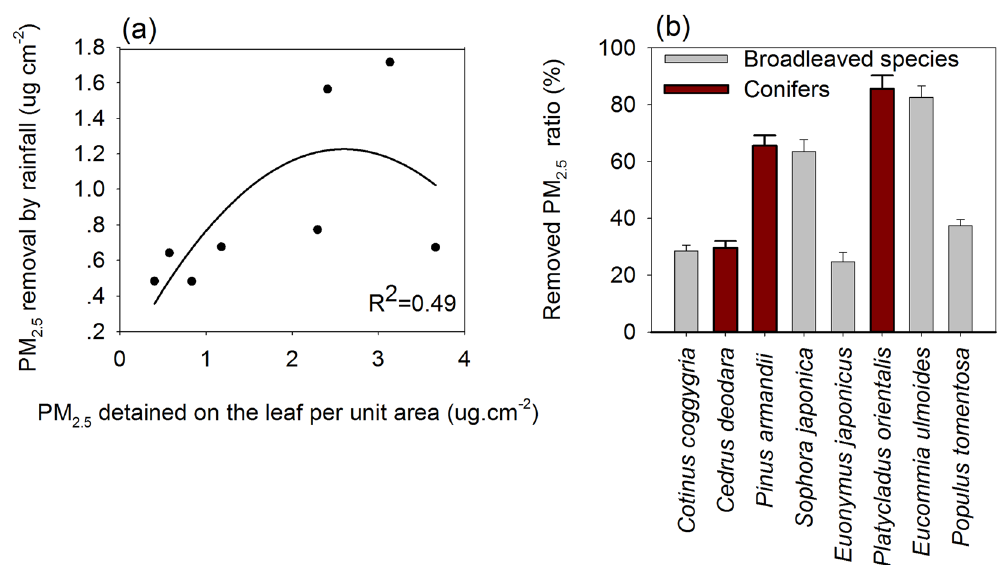
Figure 5. Foliar PM 2.5 removed by simulated rainfall (equivalent to 7.5 mm outdoor rainfall over 15 minutes) in relationship to total foliar PM 2.5 accumulation ( a ) and PM 2.5 removal percentage among species ( b